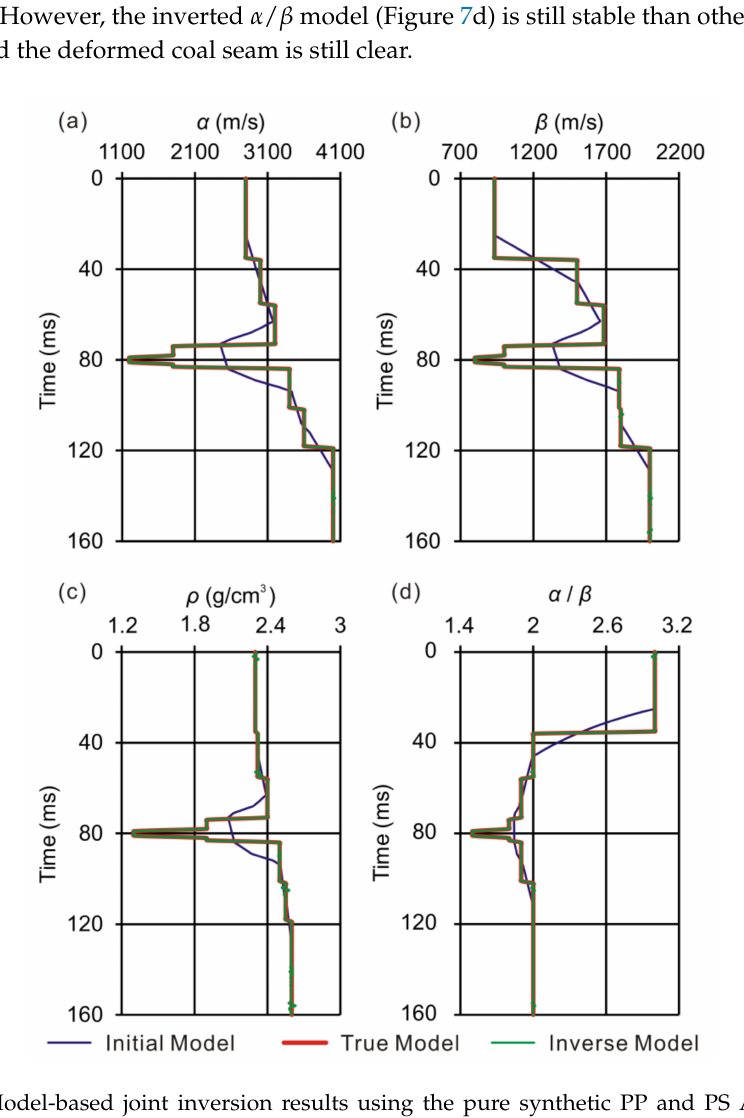
Figure 6. Model-based joint inversion results using the pure synthetic PP and PS AVA gathers: ( a ) P-wave velocity ( α ); ( b ) S-wave velocity ( β ); ( c ) density ( ρ ); and ( d ) P- to S-wave velocity ratio ( α / β